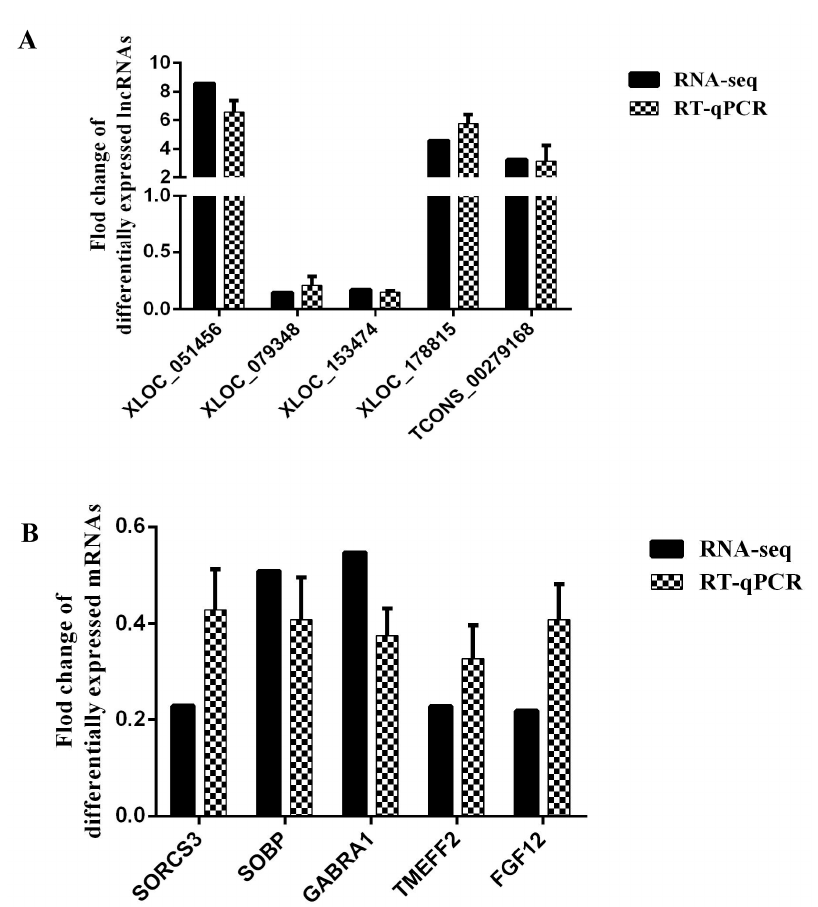
Figure 3. Differentially expressed lncRNAs and mRNAs from RNA-seq were verified using RT-qPCR. ( A ) The relative expression level of differentially expressed lncRNAs ( n = 5) based on straight wool as a control group. ( B ) The relative expression level of differentially expressed mRNAs ( n = 5) based on straight wool as a control group.